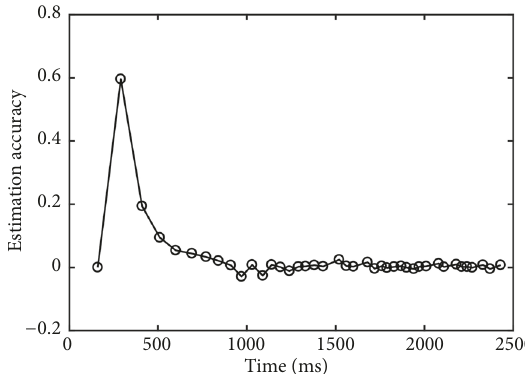
Figure12:EstimationaccuracyduringAMTstartupunderthethird